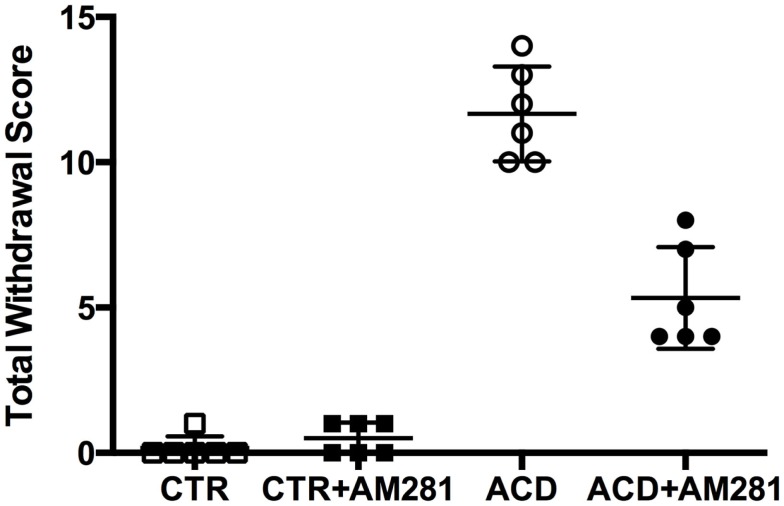
Total withdrawal score. (□) CTR, (■) CTR + AM281, (○) ACD, and (●) ACD + AM281.